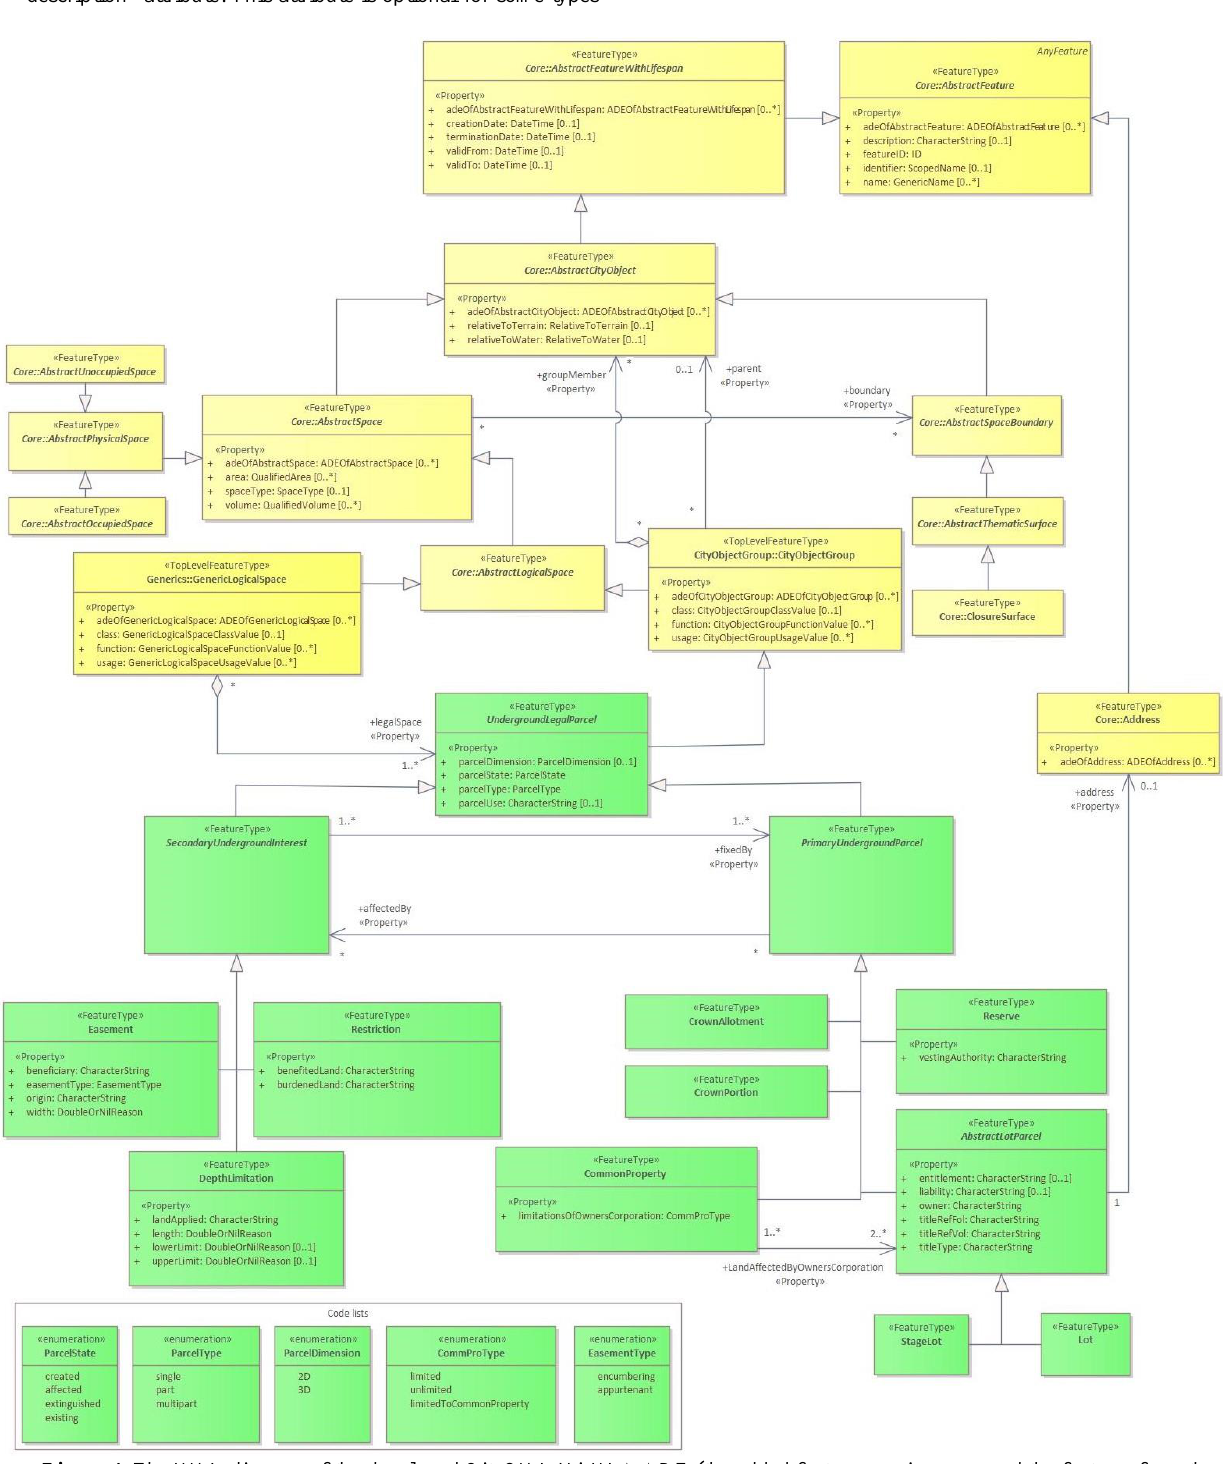
Figure 4 . The UML diagram of the developed CityGML VicULA ADE (the added features are in green, and the features from the CityGML CM are in